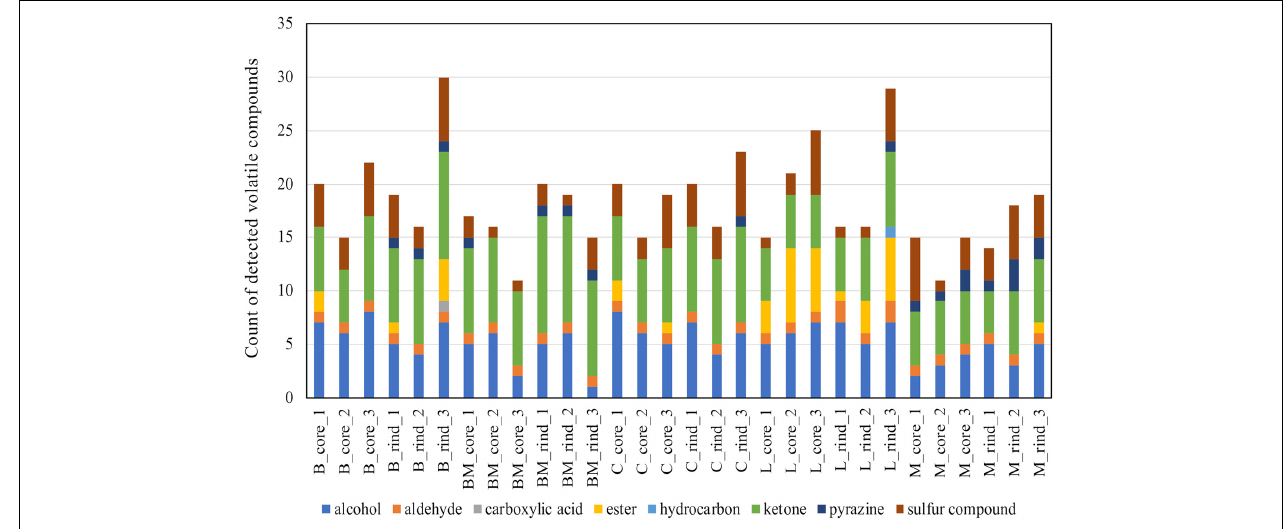
FIGURE 7 | Count data of the detected volatile compounds in 30 cheese samples. Detected compounds were classified into eight categories and aggregated. Total counts of detected volatile compounds in each sample are shown in the barplot. B, Brie de Meaux; BM, Brie de Melun; C, Coulommiers; L, Langres; M, Maroilles.